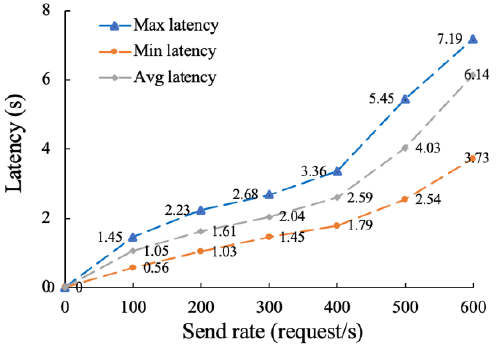
Figure 14. Latency testing of the on-chain function.